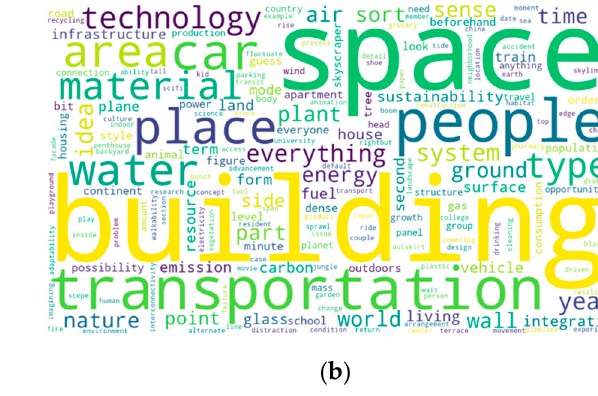
Figure 8. Word Cloud illustrating the frequency of concepts for the brainstorming tasks in a room with an algae facade ( a ) and without an algae facade ( b ).